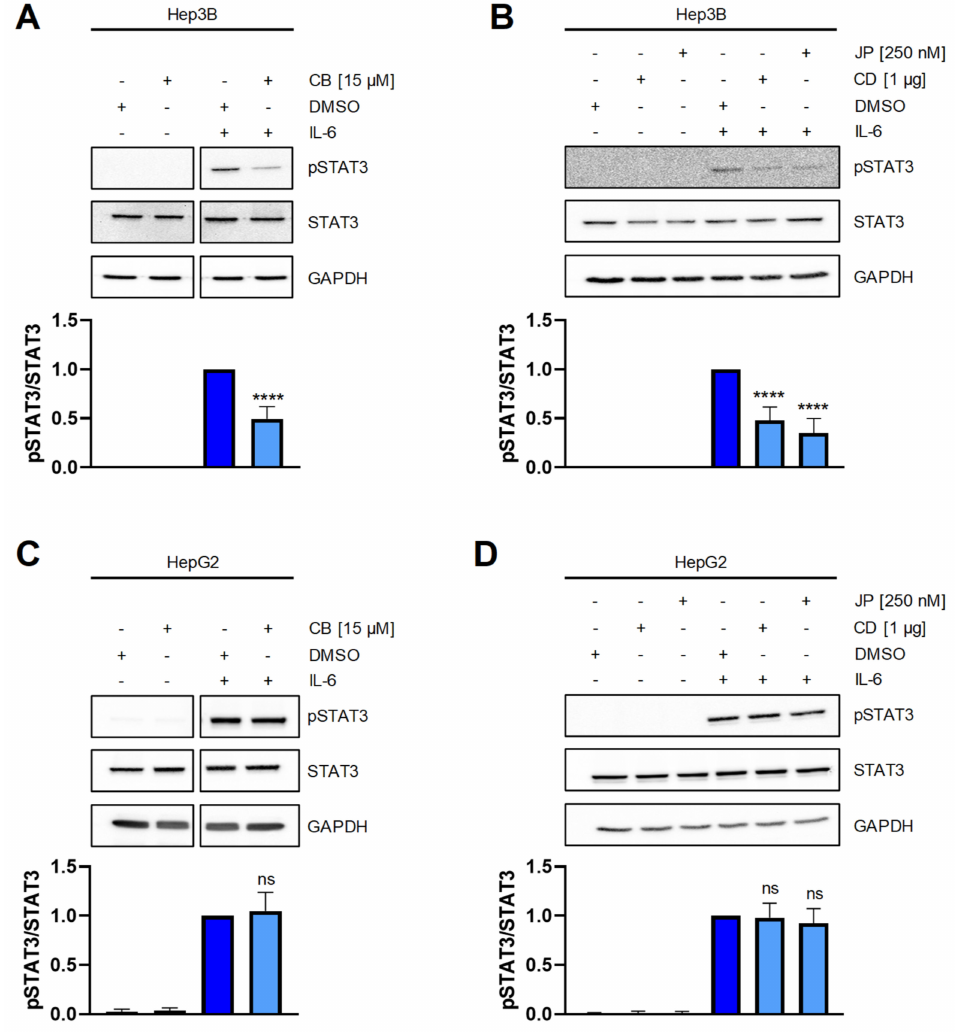
Figure 3. Perturbation of the actin cytoskeleton interferes with STAT3 signaling in Hep3B cells. ( A , B ) Hep3B cells were pretreated with cytochalasin B (15 µ M), cytochalasin D (1 µ g), jasplakinolide (250 nM) or DMSO (0.1%) as a control for 120 min. IL-6 (10 ng/mL) was added for 15min in order to activate STAT3 signaling. Representative western blot images from one experiment are shown, the quantitative data are shown as means ± SD of three independent experiments. ( C , D ) The experiments were performed as described for panels A and B, but HepG2 cells were used. Representative western blot images from one experiment are shown, the quantitative data are shown as means ± SD of three independent experiments. Statistical significance was determined using one-way ANOVA with Sidaks’s multiple comparisons test (cells pre-treated with actin-modulating compounds and stimulated with IL-6 were compared to IL-6-stimulated cells only; ****: p < 0.001; ns = no significant difference CB: cytochalasin B; CD: cytochalasin D; JP: